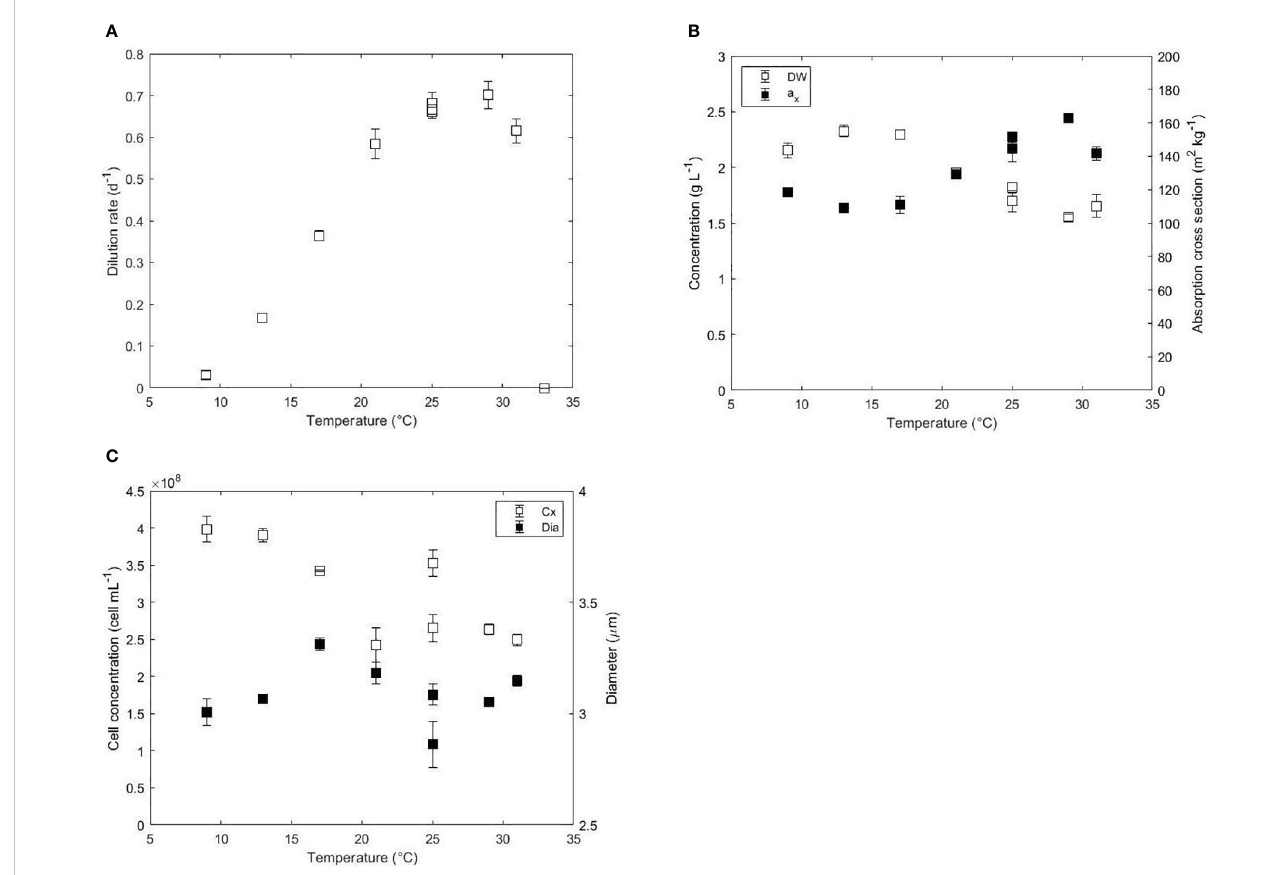
FIGURE 1 (A) Dilution rate (d -1 ), (B) biomass dry weight (g L -1 ), absorption cross section (m 2 kg -1 ), (C) cell concentration (cell mL -1 ) and diameter ( m m) as a function of the temperature (°C) in acclimated cultures of N. oceanica . Error bars represent the standard deviation of three measurements. Two independent runs were performed at 25°C to assess the reproducibility of the